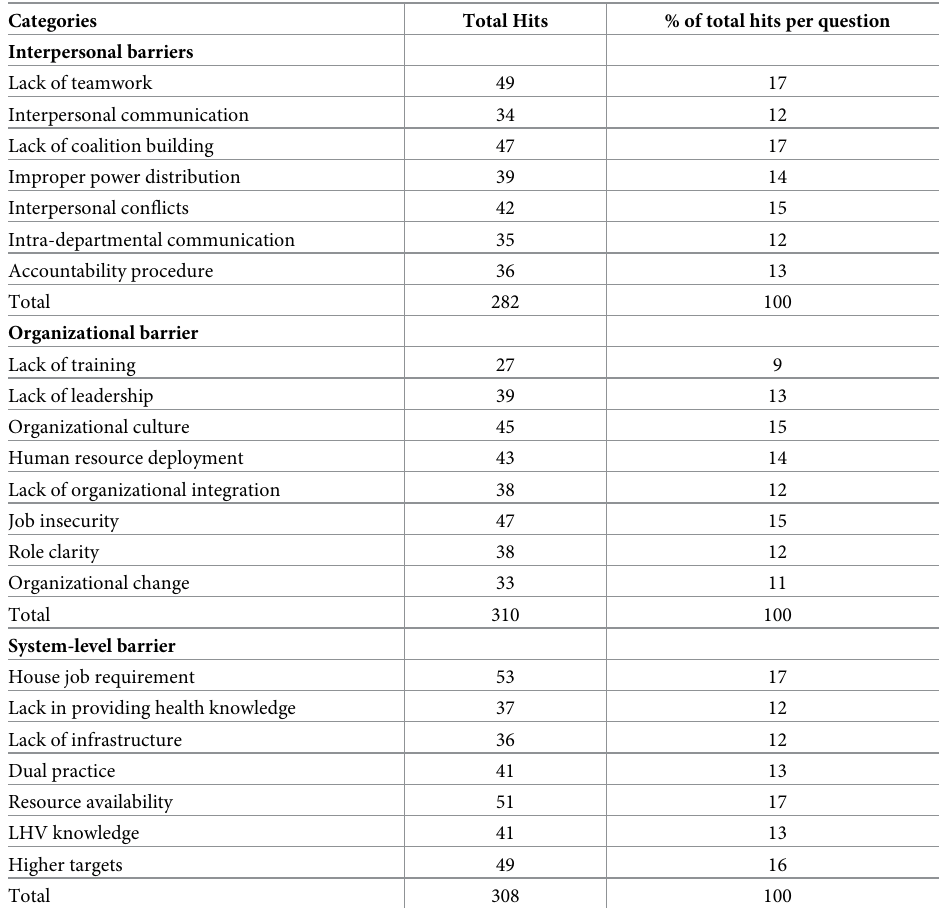
Table 2. Frequencies of